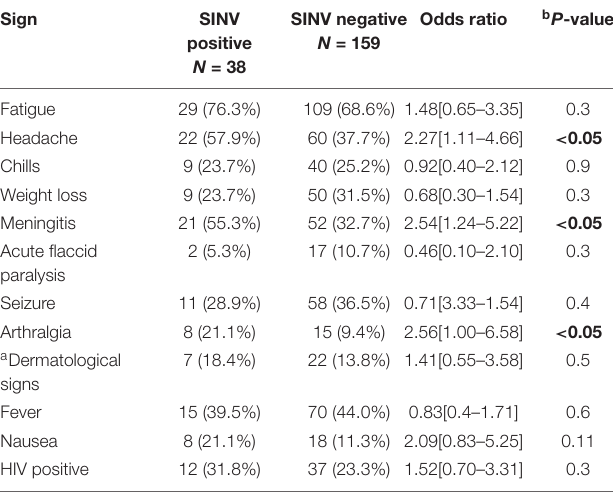
TABLE 3 | Clinical symptoms reported in AFDUC patients upon enrollment from January to June,